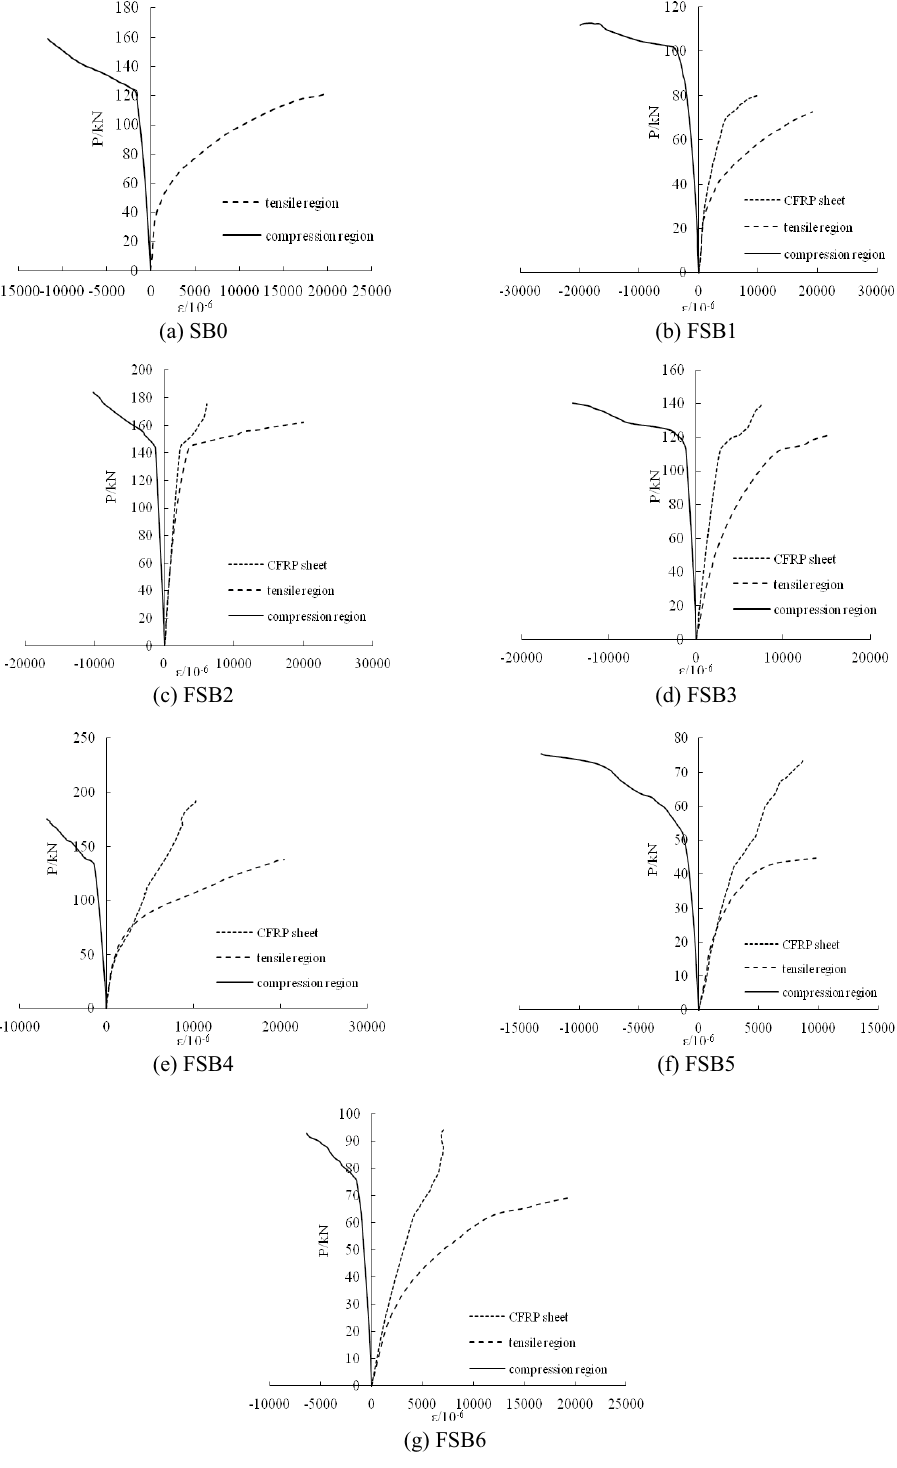
Figure 8. Load-strain curves of strengthened steel